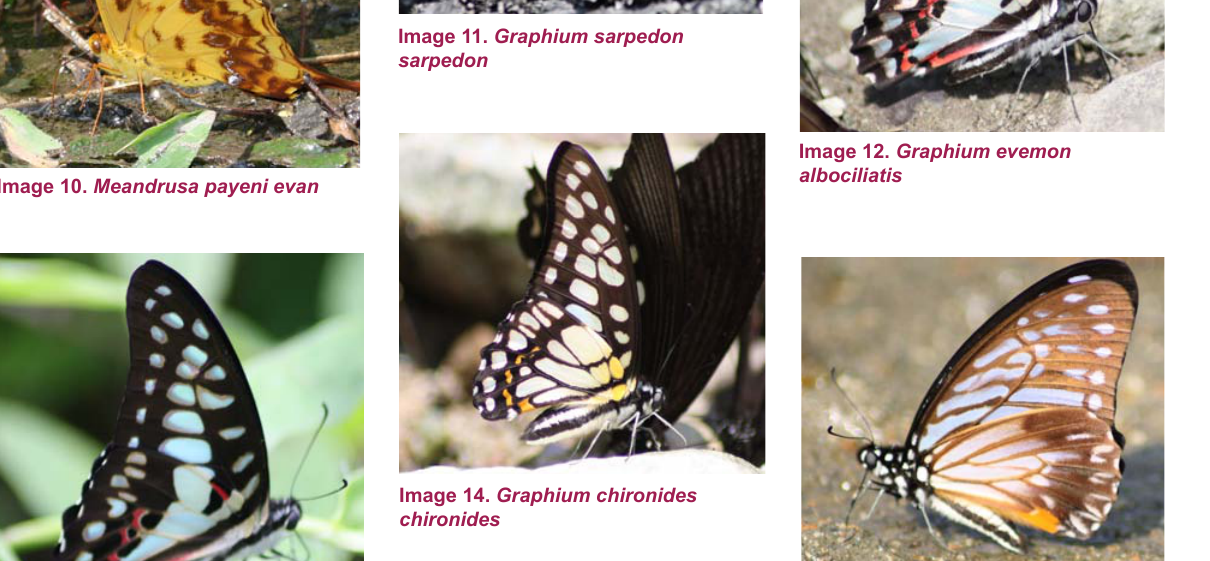
Image 11. Graphium sarpedon sarpedon